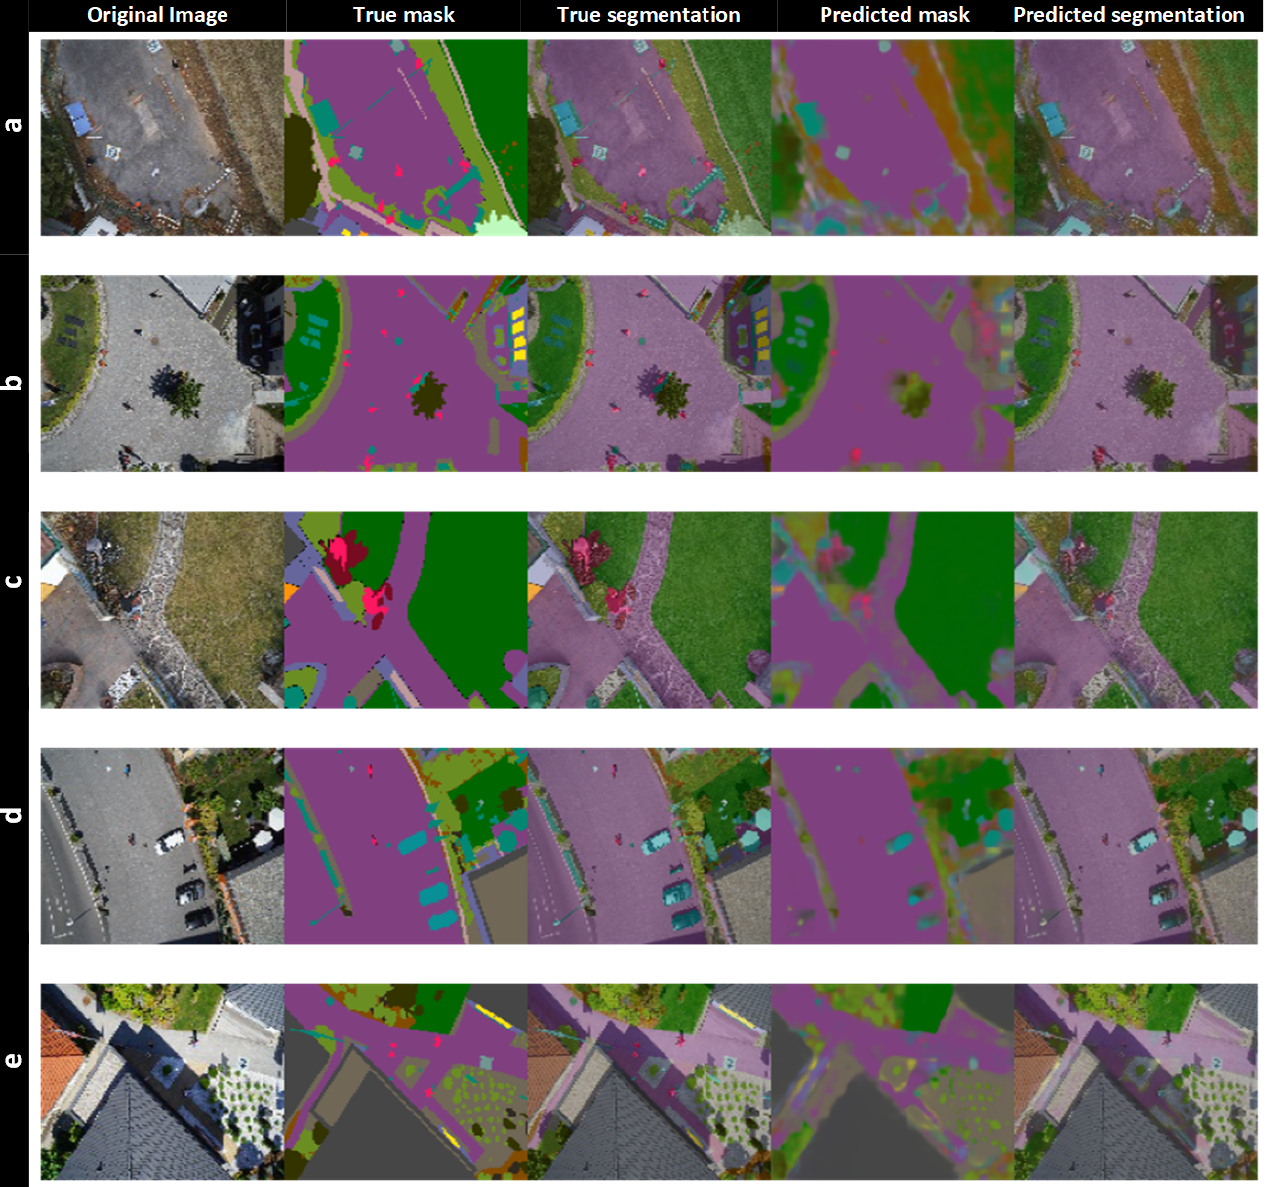
Figure 8. Multiple object segmentation results are shown row-wise from ( a – e ) for the model using aerial drone data. The first column represents original images, the second presents true mask, the third shows the true segmented mask, whereas the last two columns show the predicted mask and segmentation